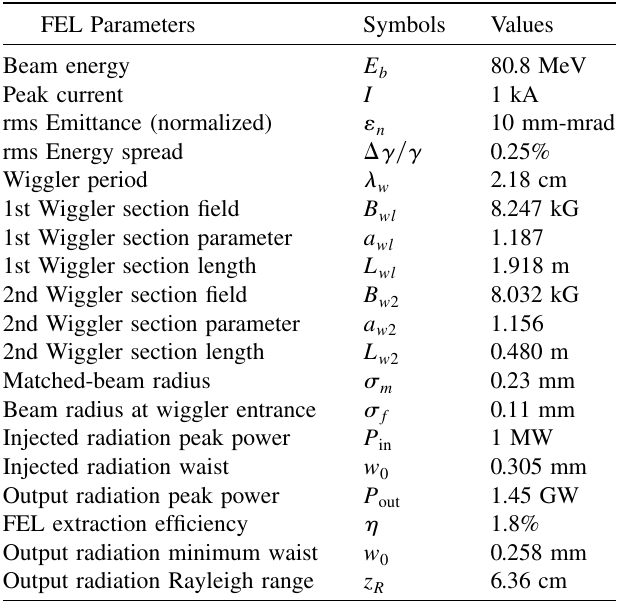
TABLE I. FEL and beam parameters used in MEDUSA simula-